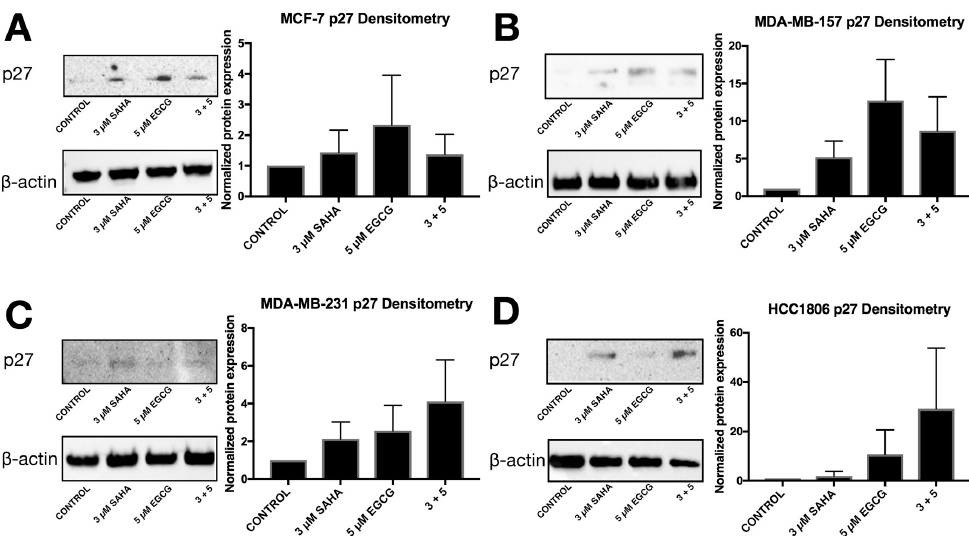
Figure 5. The overall protein level of p27 is restored with the combination of SAHA and EGCG. ( A ) Western blot protein analysis using p27 antibodies was performed using MCF-7 cells after 3-day treatments with the indicated compounds ( n = 3) (Cell Signaling Technologies, Danvers, MA, USA). β -actin was used for comparison. Densitometry analysis was completed using ImageJ software ( n = 3). ( B – D ) The same was done in MDA-MB-157, MDA-MB-231, and HCC1806 triple-negative cell lines. Pictures are representative of the replicates; densitometry is an average of all three replicates. The same blots were probed multiple times, explaining the duplication of β -actin between